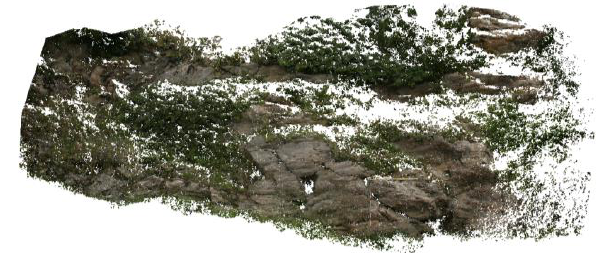
Figure 15. SURE Canon5D dense point cloud